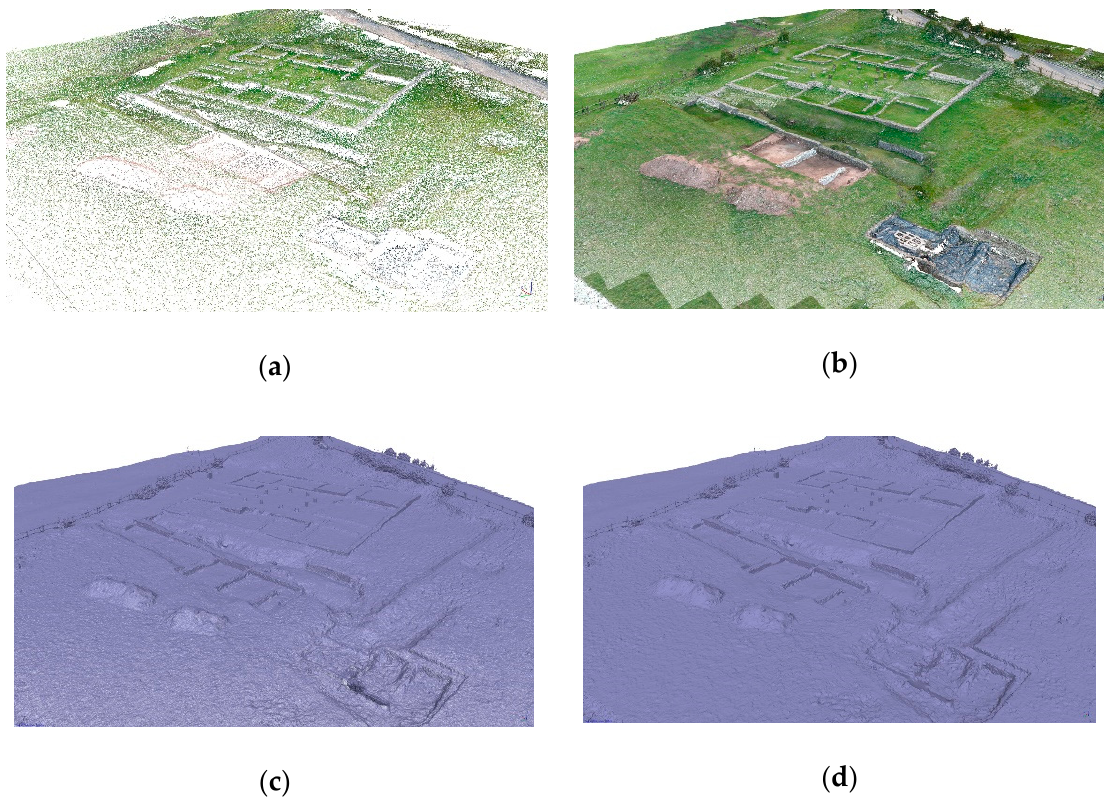
Figure 7. Graphic outputs obtained from the most accurate flight. ( a ) Point-cloud. ( b ) Dense point-cloud. ( c ) Wireframe model. ( d ) Triangulated model.